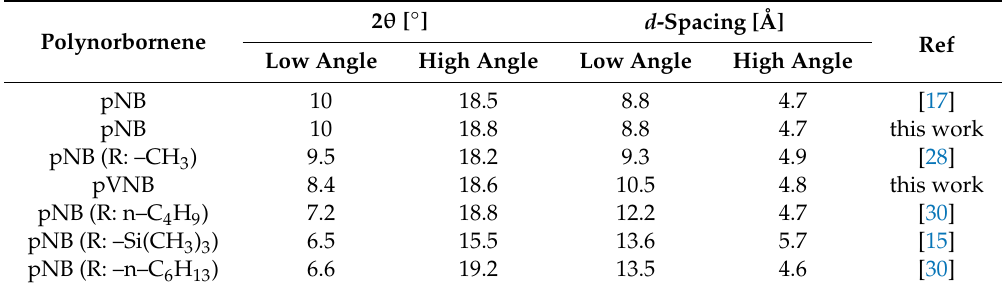
Table 3. WAXS data for addition type polynorbornenes with different side groups (R).